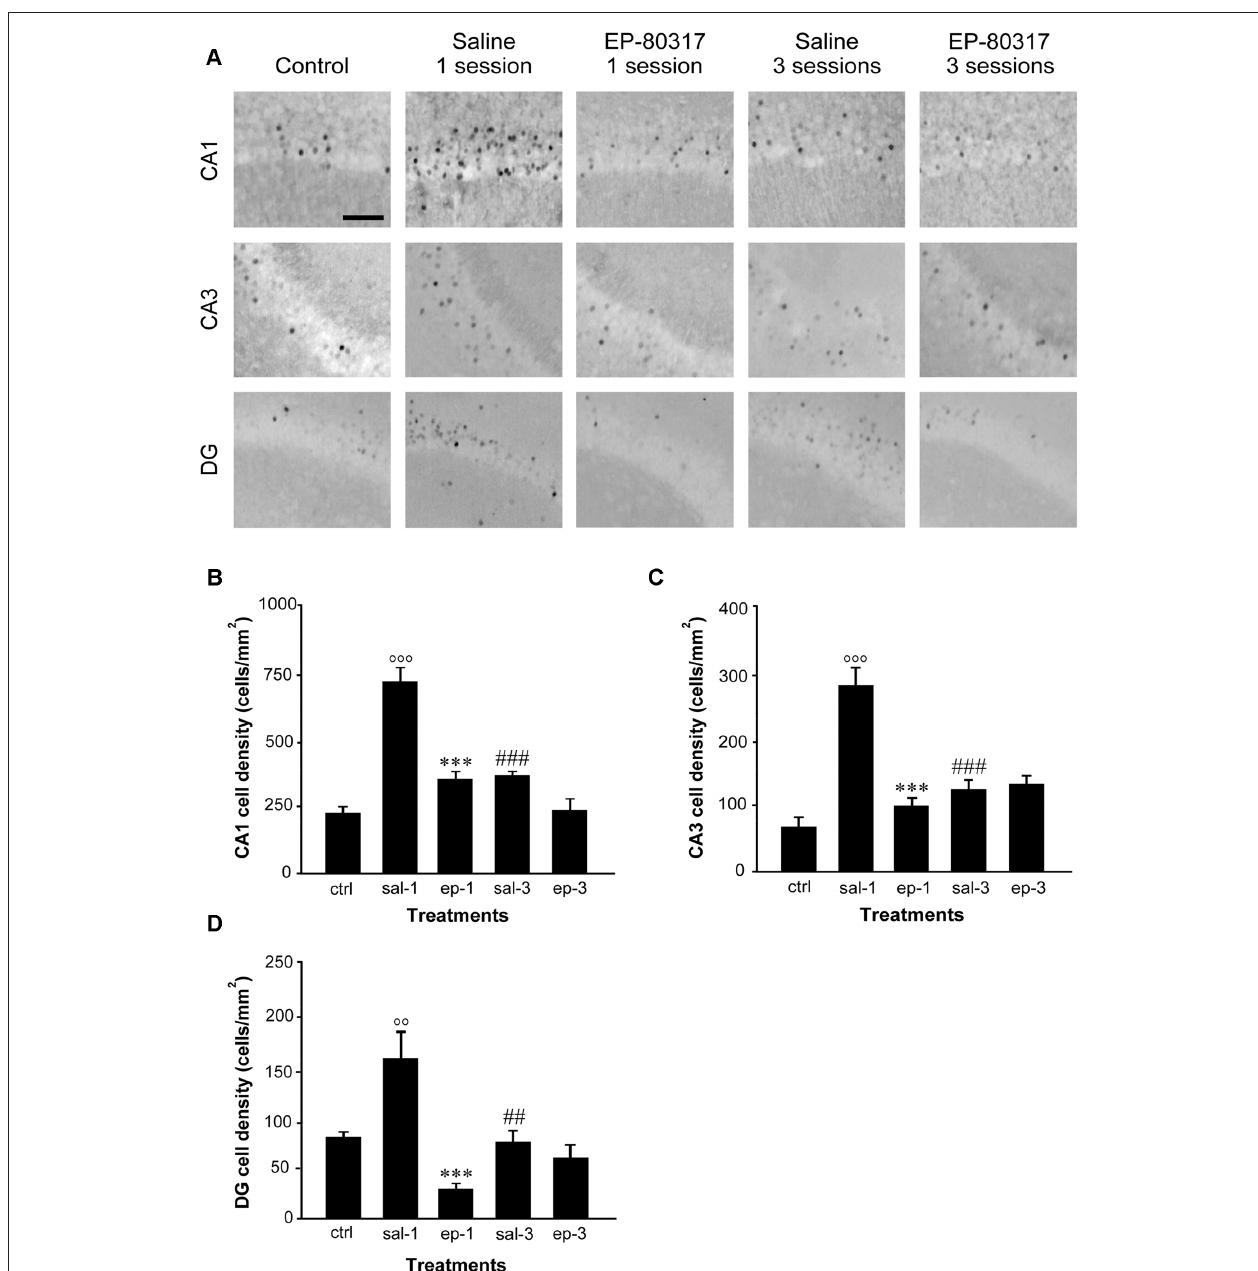
FIGURE 3 | FosB/ ∆ FosB immunoreactivity in hippocampal regions of mice treated with saline or EP-80317 and exposed to different sessions of 6-Hz corneal stimulation. In (A) , FosB/ ∆ FosB immunoreactivity is illustrated in CA1, CA3, and dentate gyrus (DG), in a representative unstimulated control (ctrl) mouse. Besides, FosB/ ∆ FosB immunoreactivity is also shown in mice exposed to one or three different sessions of 6-Hz corneal stimulation, and pretreated with saline (sal) or EP-80317 (ep). Immunoreactivity was measured and results are illustrated in (B–D) . Note that FosB/ ∆ FosB levels were significantly increased in CA1 (B) , CA3 (C) , and DG (D) after the first session, in saline-treated mice only ( ◦◦ P < 0.01, ◦◦◦ P < 0.001 vs. controls; Fisher’s least significant difference test). In EP-80317-treated mice, FosB/ ∆ FosB levels were instead maintained at basal values and were significantly different from saline-treated mice ( ∗∗∗ P < 0.001 vs. sal-1). Note also that FosB/ ∆ FosB levels were significantly reduced in the third session of saline-treated mice ( ## P < 0.01, ### P < 0.001 vs. sal-1). Scale bar, 50 µ